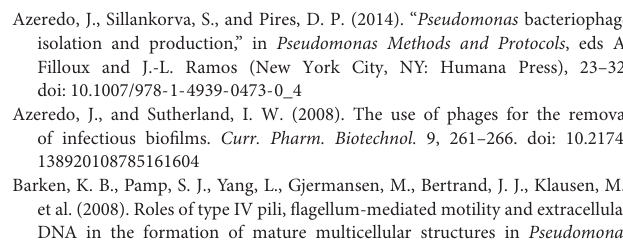
FIGURE S1 | Phage susceptibility assays. (A) One drop of phage suspension is placed on the Petri dish and allowed to run down the plate (vertical line). (B) Once dry, several bacterial colonies are picked and streaked against the phage (horizontal line). (C) After overnight incubation, the susceptibility of the bacterial strains to the phage is evaluated. (D) Example of a phage susceptibility assay using phage LUZ19. FIGURE S2 | Number of viable cells present in 24-h biofilms of P. aeruginosa PAO1 wild-type (WT) and phage-resistant variant strains (V3, V4, V6, V7, and V10). FIGURE S3 | SDS–PAGE of LPS-banding profiles of P. aeruginosa PAO1 wild-type and phage-resistant variant strains (3, 4, 6, 7, and 10) complemented with galU